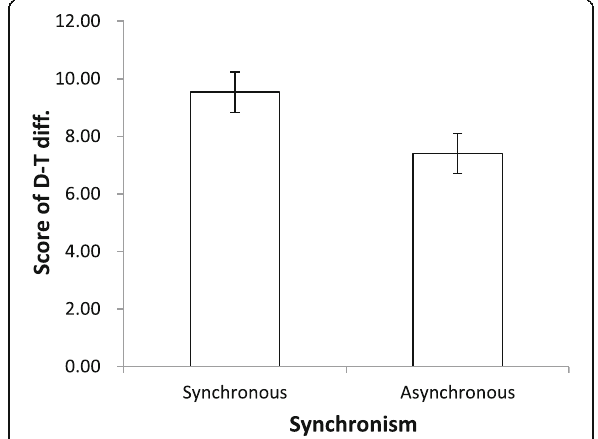
Fig. 3 Mean D-T diff. scores during the synchronous and asynchronous conditions. Error bars represent the standard error of the mean